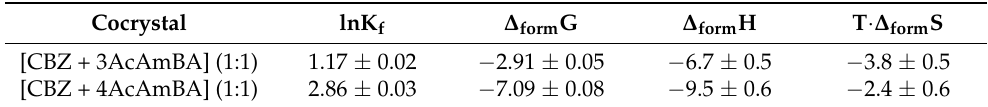
Table 2. Equilibrium constants and thermodynamic functions (in kJ · mol − 1 ) of the CBZ cocrystal formation at